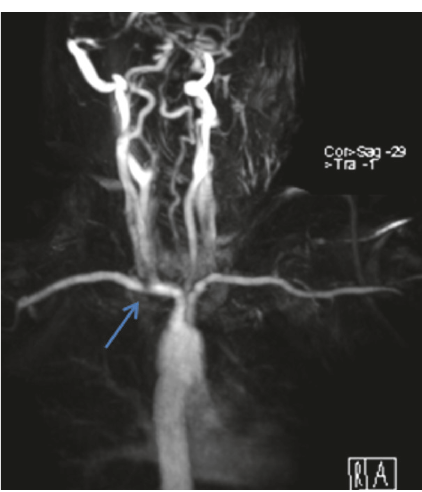
Figure 1: MRI showing compression (arrow) of the right subclavian artery.